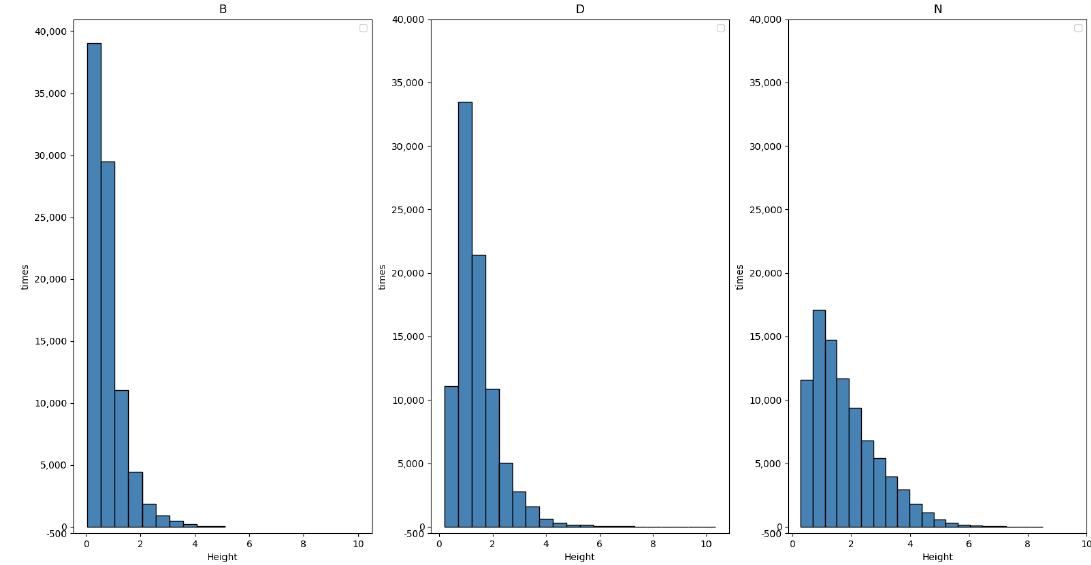
Figure 2. Histogram of significant wave height distribution. The three subgraphs represent the significant wave height distribution histograms of the B, D, and N points from left to right.